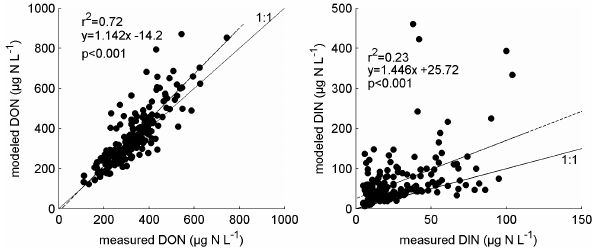
Figure 4. Results of the mass-balance modeling approach for DON (left) and DIN (right) for the downstream site BA-1.